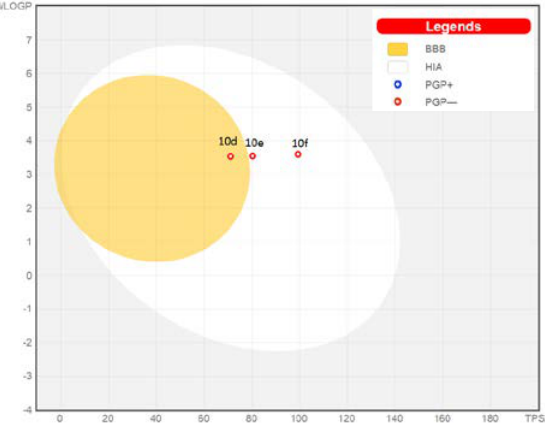
Figure 9. Boiled egg chart, generated from SwissADME online web tool, showing the high oral absorption of benzimidazole derivatives, 10d – f , and the probability of compound 10d only to penetrate the BBB.